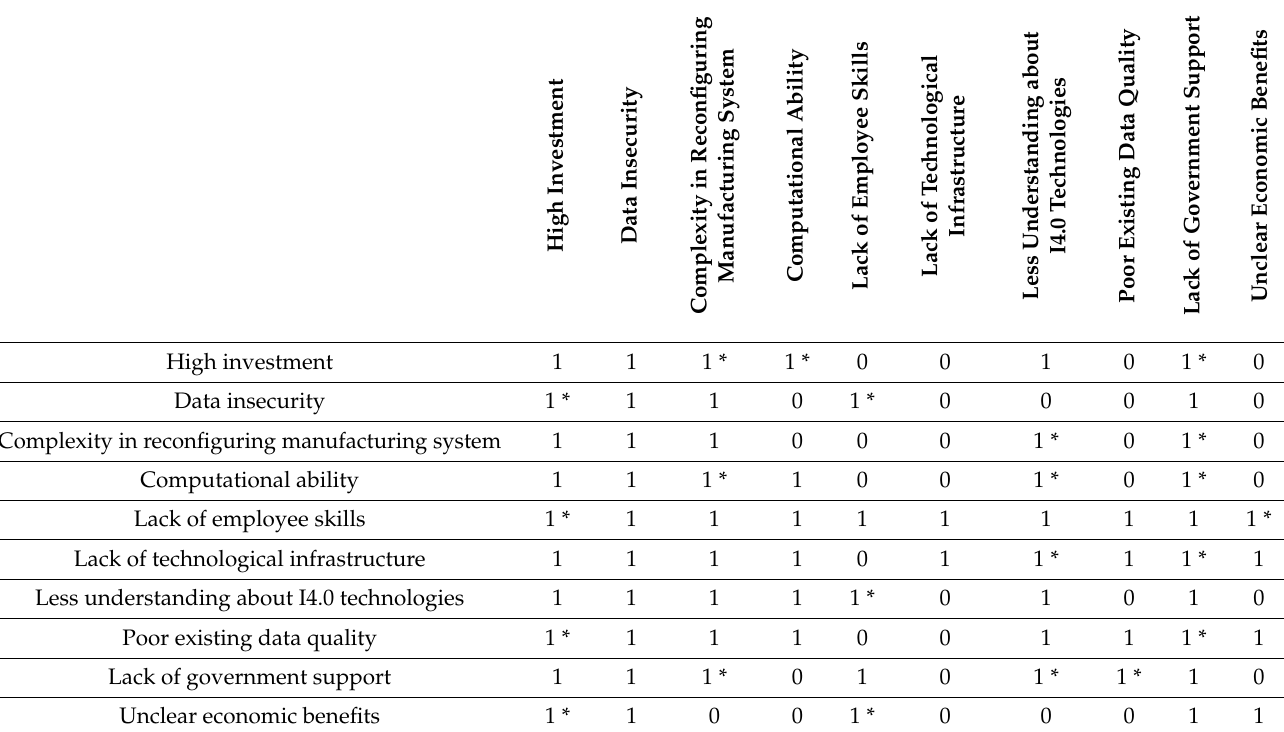
Table 5. Final reachability matrix for I4.0